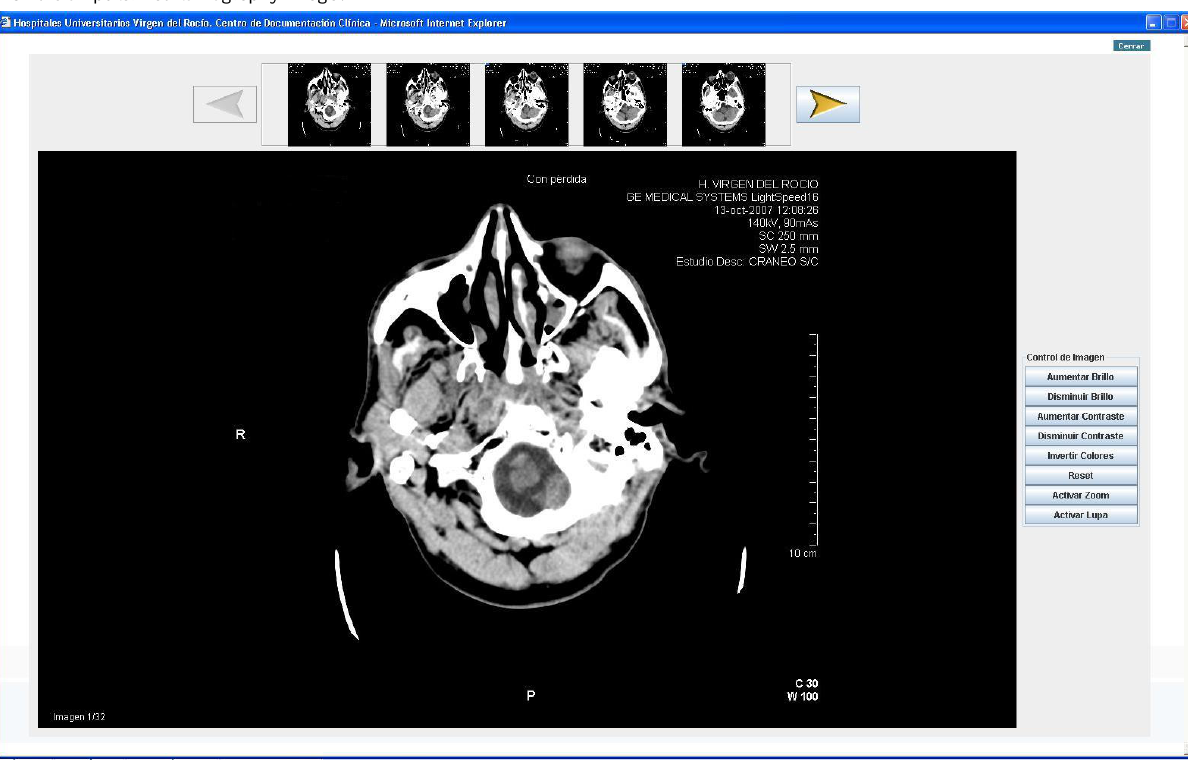
Figure 2. Computerized tomography